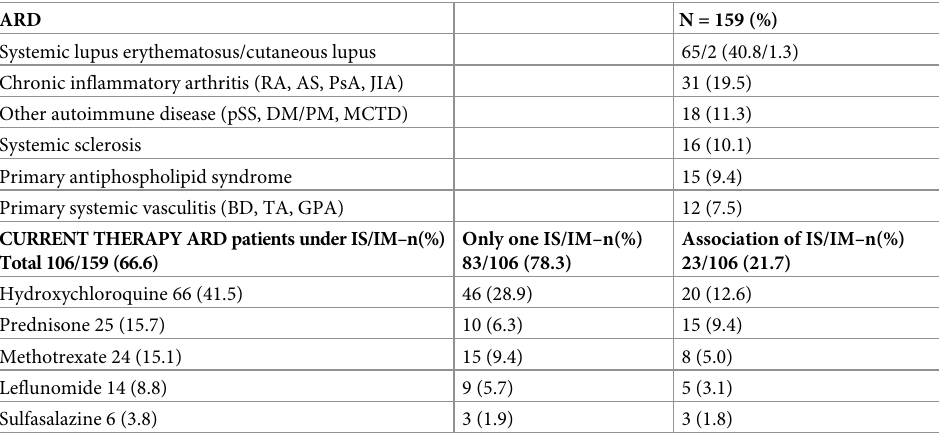
Table 2. Frequencies of autoimmune rheumatic diseases (ARD) and current patients’ therapy. ARD N = 159